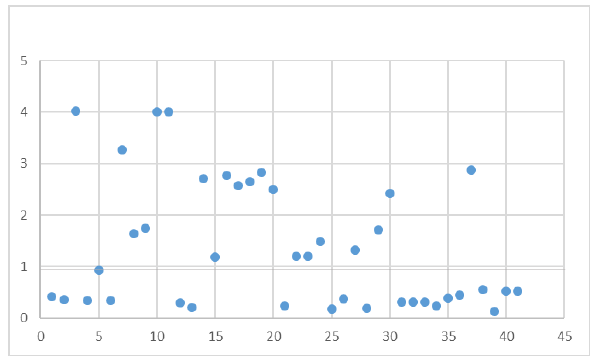
Fig.5 viewpoints and Classification of X-values